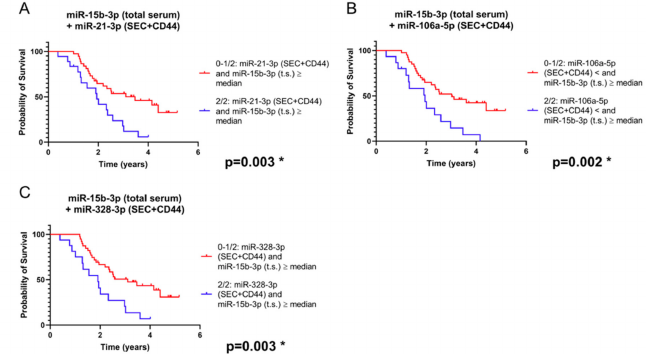
Figure 6. Survival analysis based on a combination of microRNA levels in total serum (t.s.) and / or SEC + CD44 EVs (combinations: miR-15b-3p in t.s. plus ( A ): miR-21-3p in SEC + CD44 EVs; ( B ): miR-106a-5p in SEC + CD44 EVs; ( C ): miR-328-3p in SEC + CD44 EVs). Depicted are survival curves using a dichotomous assessment from glioblastoma patients ( n = 55) in both SEC + CD44 separated serum EVs and total serum. Blue color indicates patients whose microRNA profile fulfils both conditions, while red color indicates patients whose profile fulfils at most one out of two conditions. Note that the combination of miR-15b-3p in serum with each of these four microRNAs in SEC + CD44 EVs allowed for a prognostic stratification of this patient population, even after Benjamini–Hochberg correction (Table